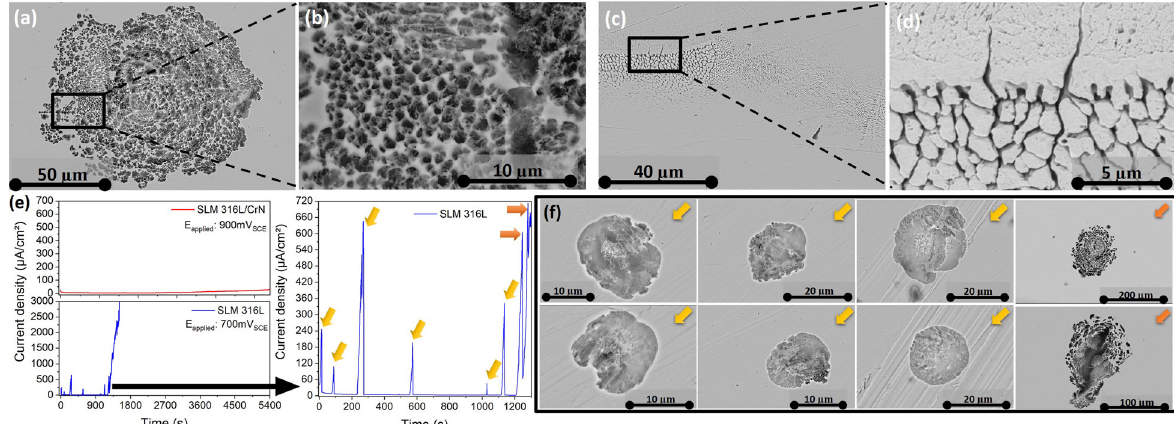
Fig. 6 Post-corrosion characterization after corrosion testing in 3.5 wt% NaCl. BSE micrographs of ( a , b ) SLM-316L and ( c , d ) SLM-316L/CrN after potentiodynamic polarization. ( e ) Potentiostatic polarization curves of SLM-316L and SLM-316L/CrN conducted at applied potential (E applied ) of 700 mV SCE and 900 mV SCE , respectively. f BSE micrographs of metastable pits after potentiostatic polarization of